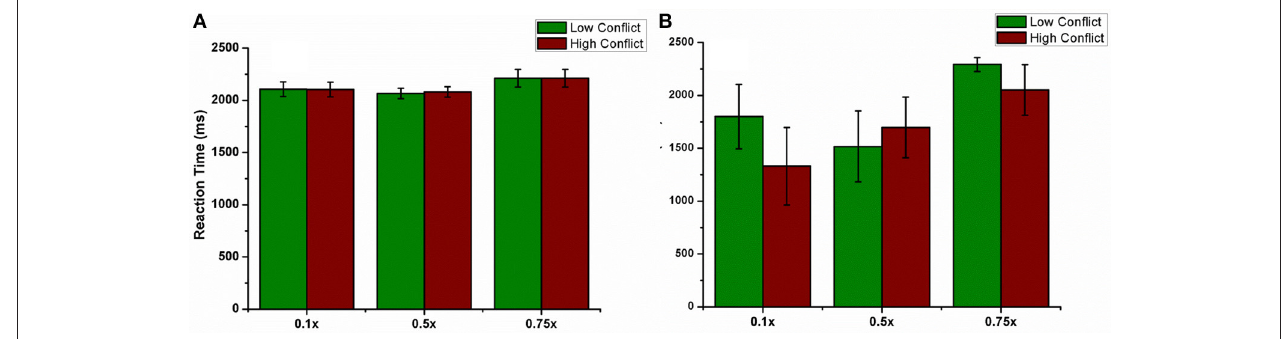
FIGURE 12 | shows the effect of antidromic activation on the behavior during PLT. Reaction time obtained, (A) for correct trials and (B) for error trials when the percentage of DBS current was varied (10, 50, and